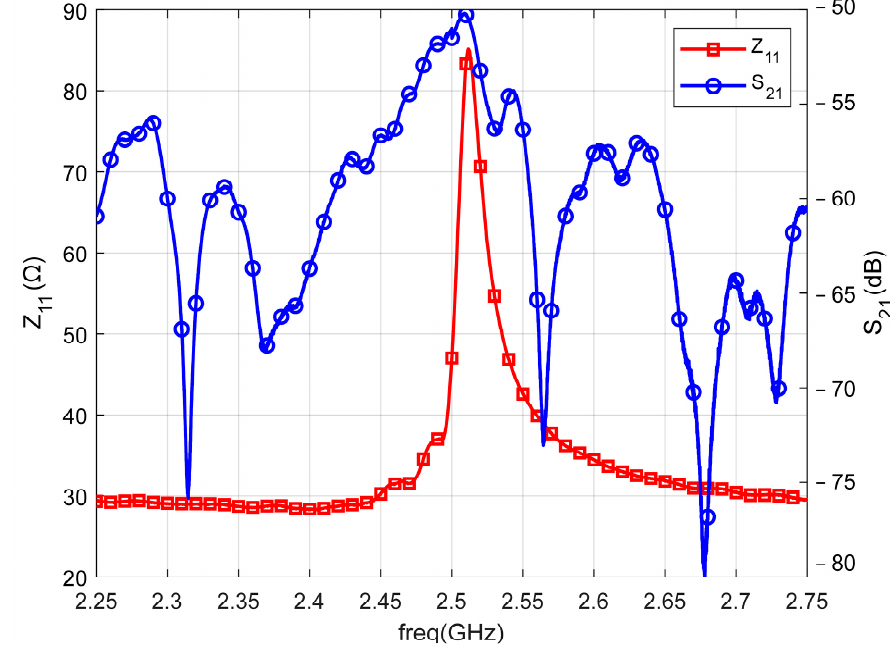
Figure 16. Z11 and S21 parameters of the antenna.